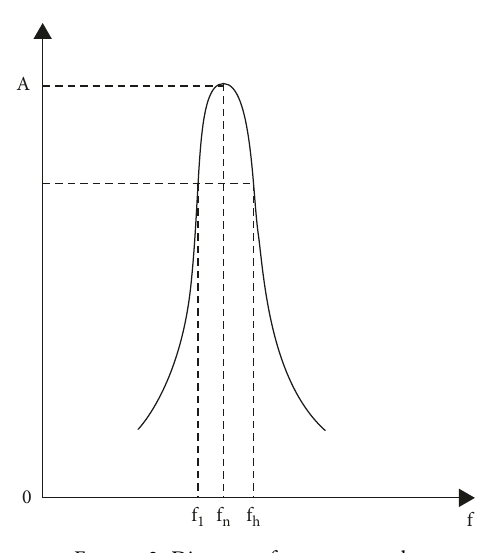
Figure 2: Diagram of resonant